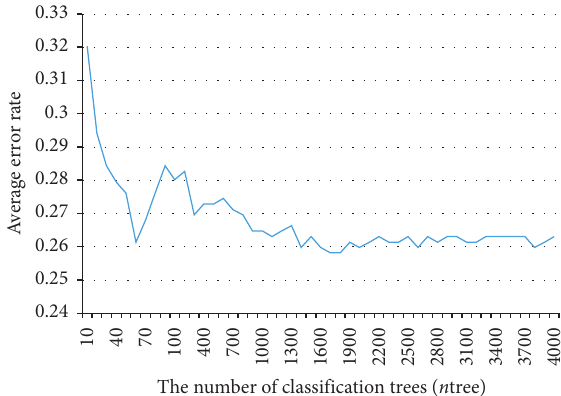
Figure 3: Average error rate of hyperparameter tuning.